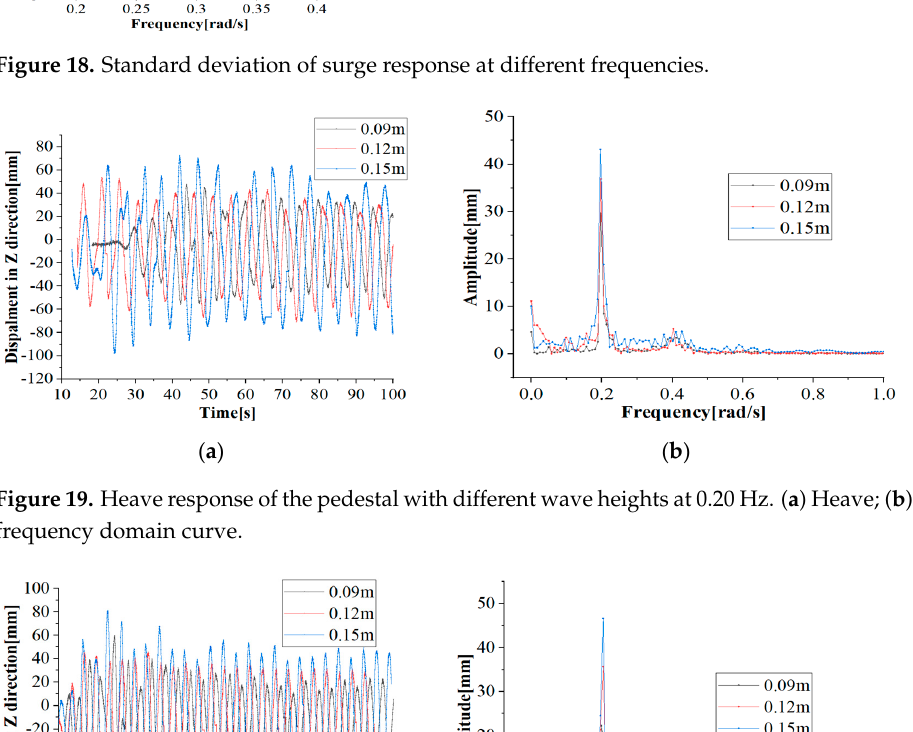
Figure 19. Heave response of the pedestal with different wave heights at 0.20 Hz. ( a ) Heave; ( b ) heave frequency domain curve.